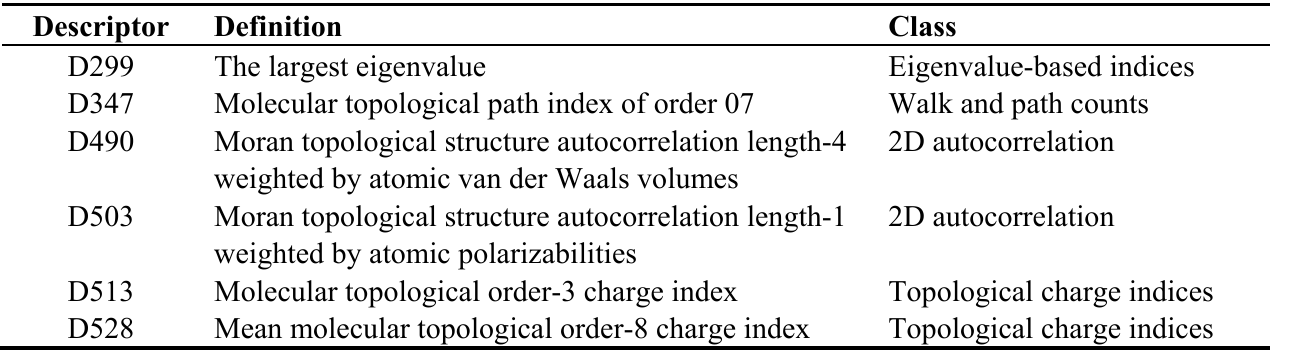
Table 1. The selected 6 Mold 2 descriptors using variable selection algorithm coupled with random forests (VS-RF) and their definition.